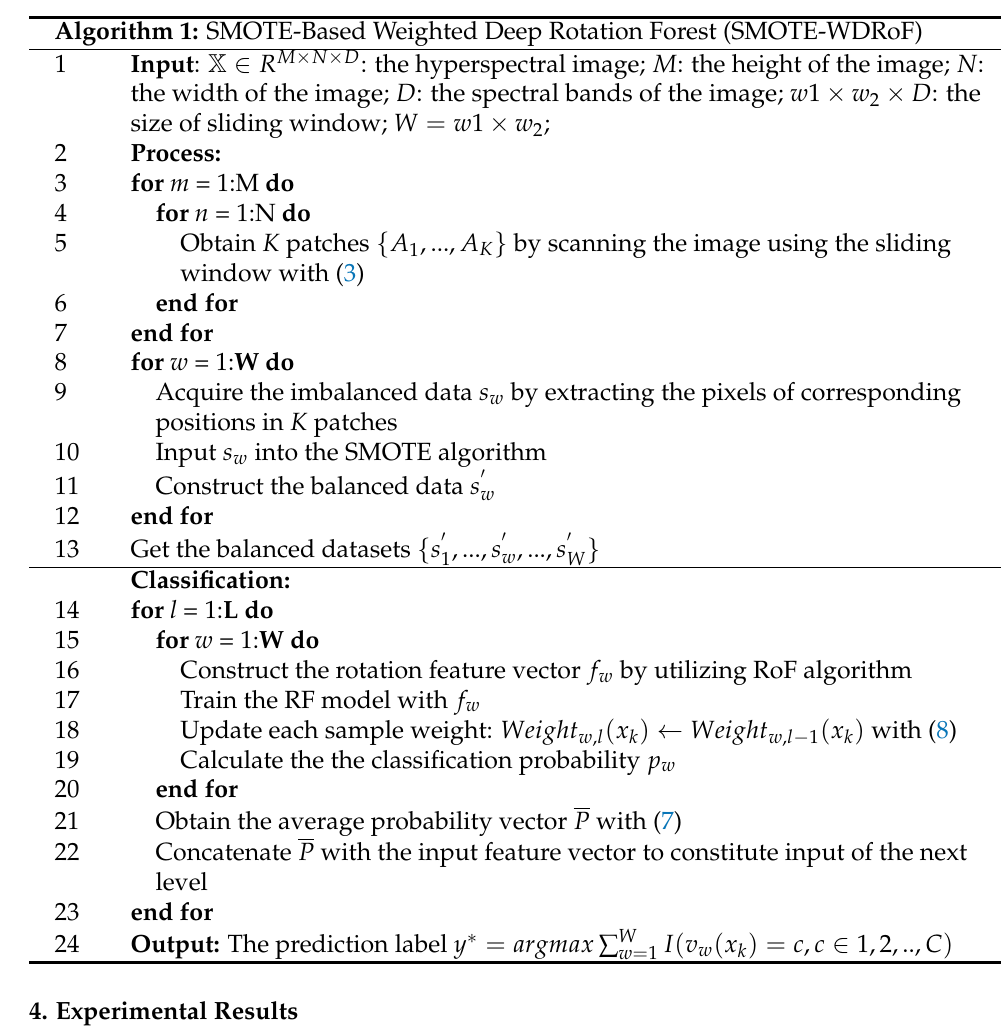
Algorithm 1: SMOTE-Based Weighted Deep Rotation Forest